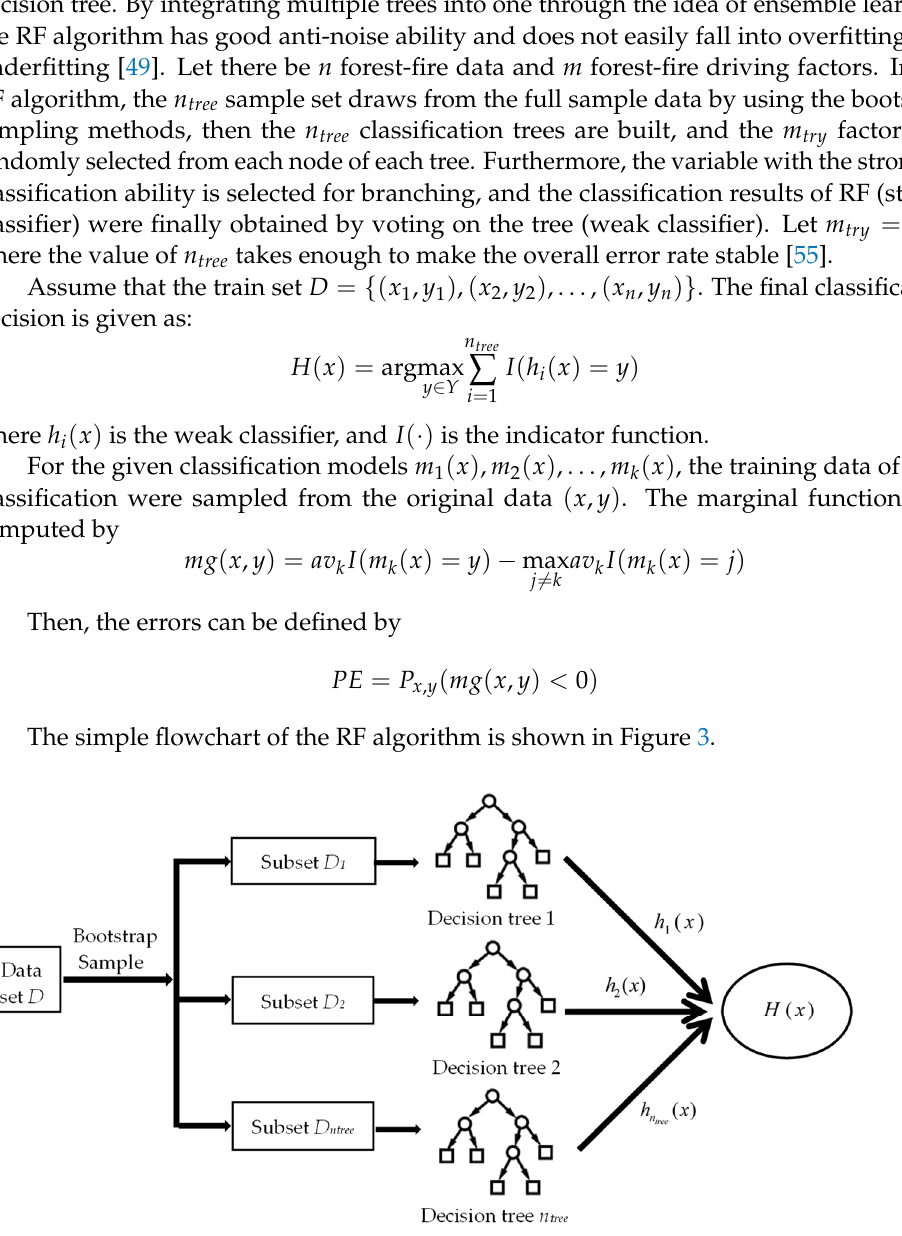
Figure 3. The simple flowchart of the RF algorithm.